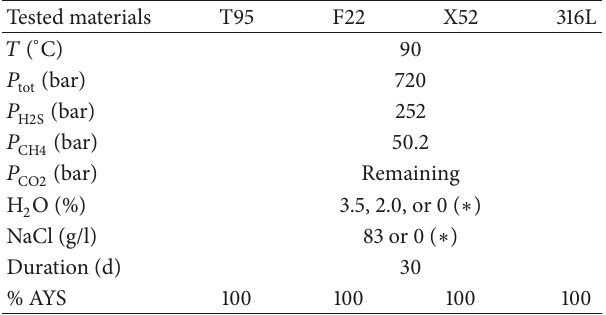
Table 2: Operating conditions simulating reinjection in well.